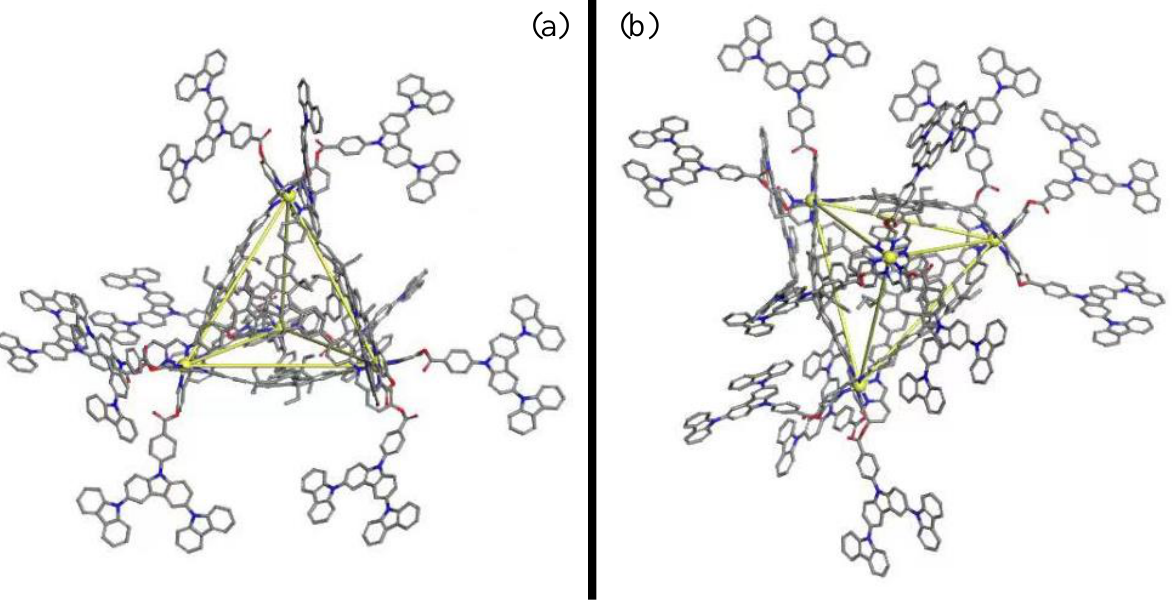
Figure 4. ( a ) Energy-minimized molecular structure of Cage-1 (Zn, yellow; N, blue; O, red; C, gray). Hydrogens and counteranions are omitted for clarity (( a ) side view and ( b ) top view of Cage-1 ).